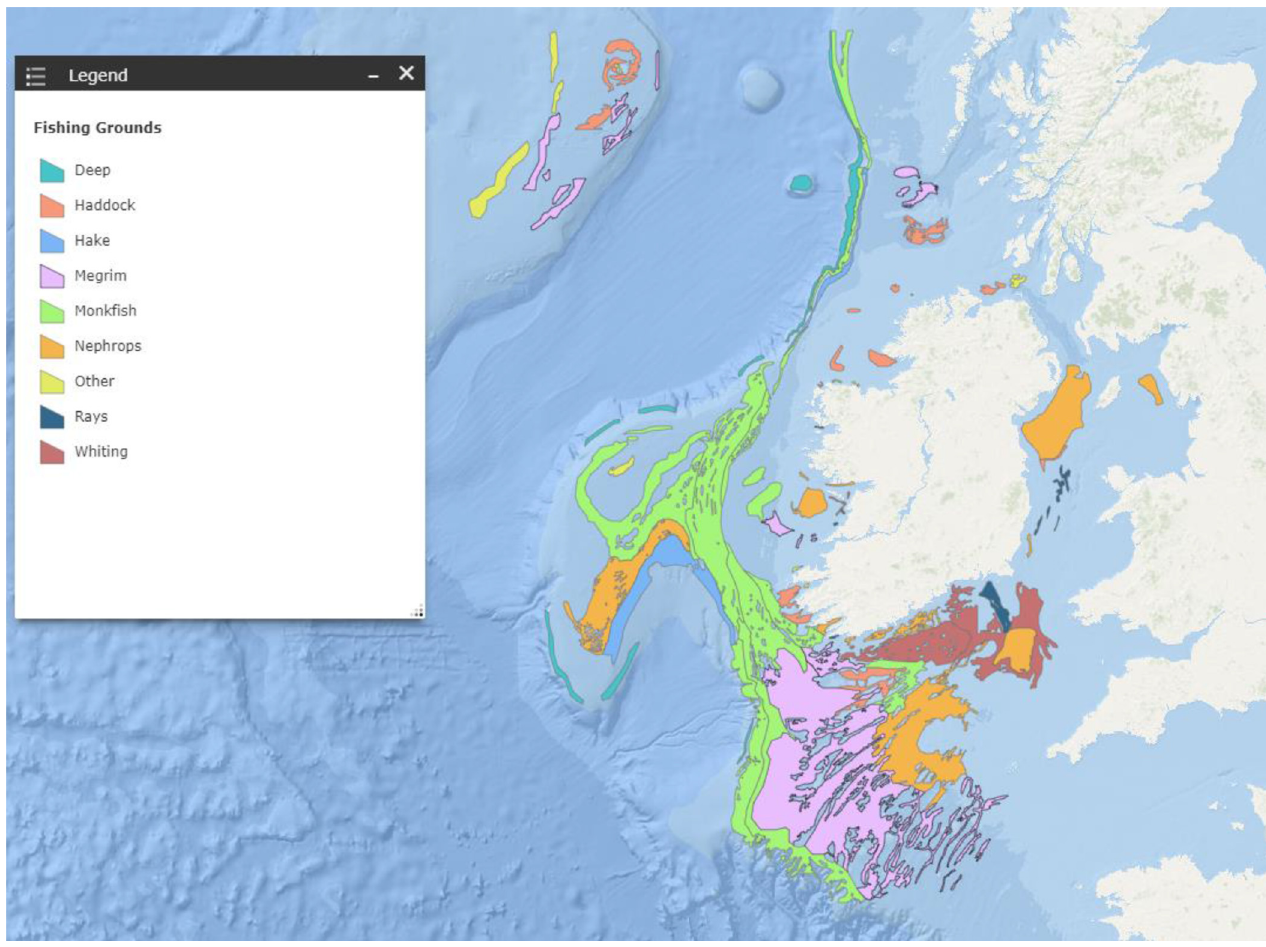
Fig. 1. Important fi shing grounds around Ireland; source BIM Inshore Fishery GIS